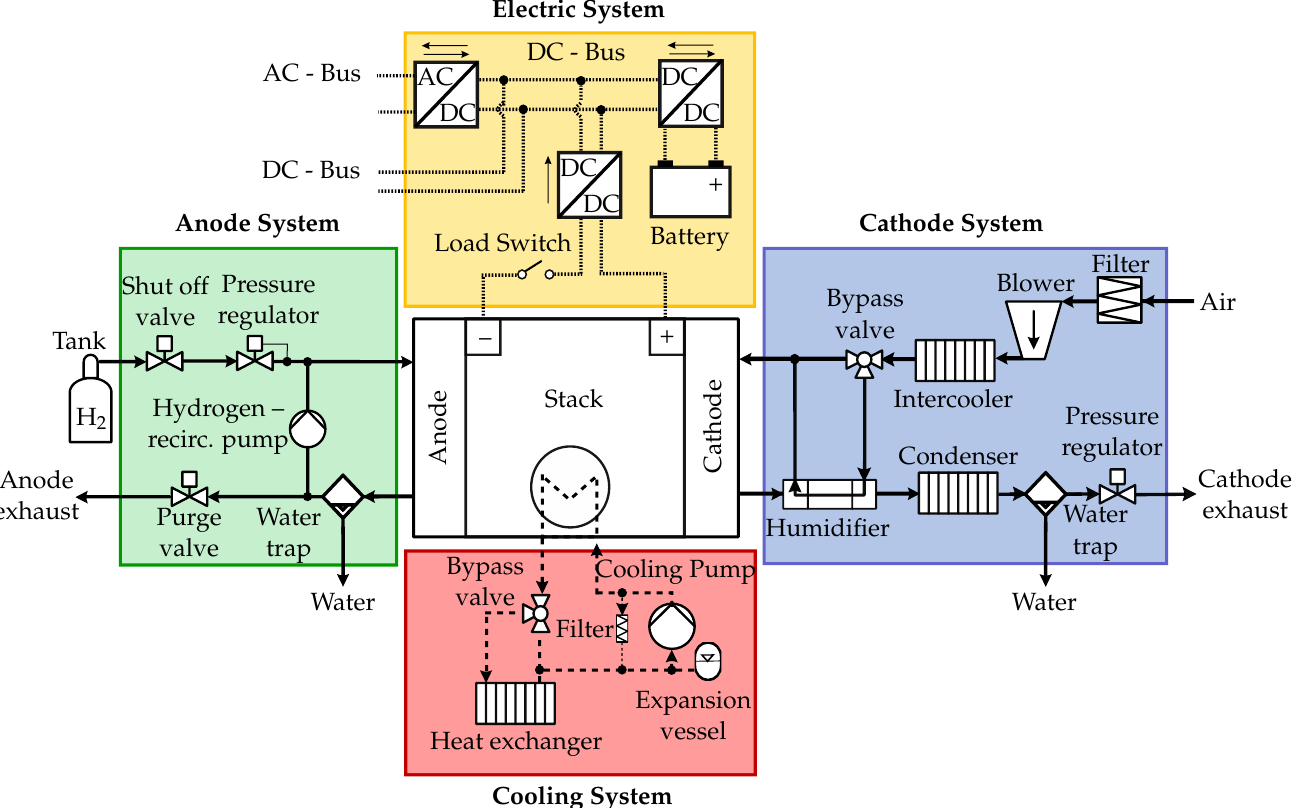
Figure 2. Exemplary illustration of a PEMFC, including stack and surrounding